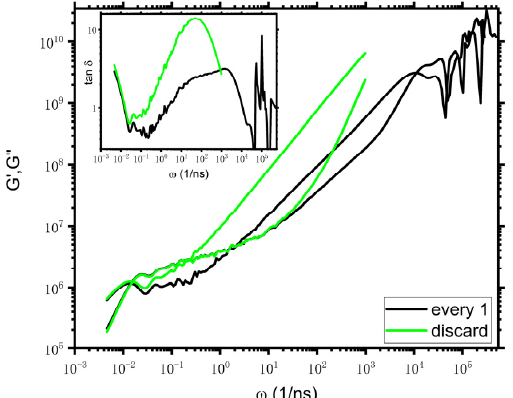
Figure 6. Viscoelastic moduli of PE. The absolute values of G ( t ) are input into i-Rheo GT , and the value of G ( 0 ) is 14.5 GPa. The inset shows tan δ vs. frequency. The legends of “every 1” and “discard” mean that the stress is calculated at every timestep, and the data of G ( t < 10 − 3 ns ) of “every 1” are discarded, respectively.